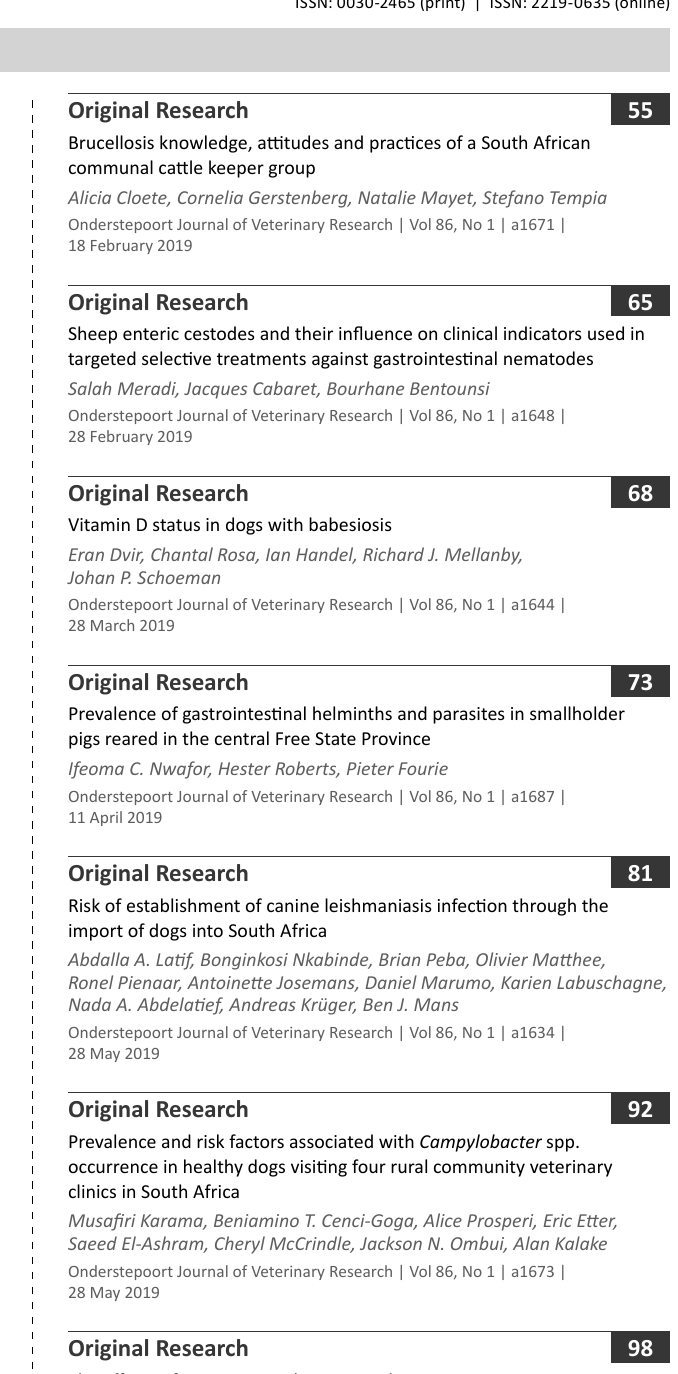
The effects of extraction techniques and quantitative determination of oxalates in Nerium oleander and feeds Kedibone G.